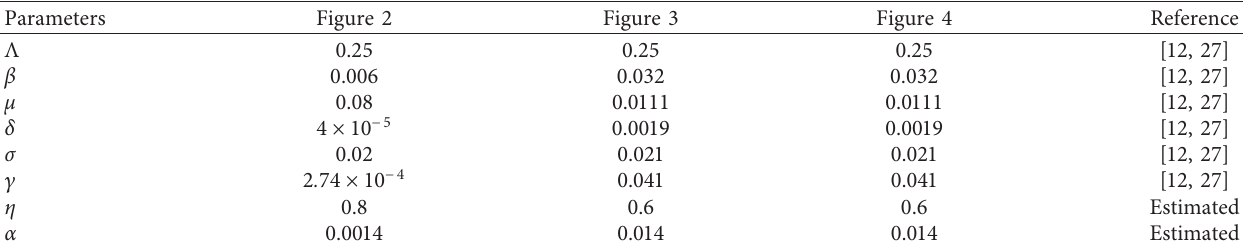
Table 1: The estimation of the problem parameters. Figure 2 Figure 3 Figure 4